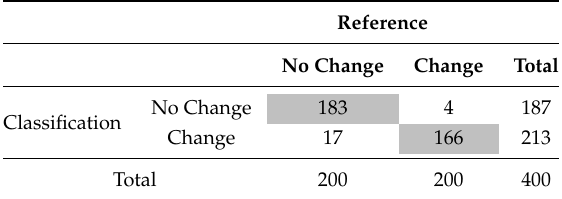
Table 5. Change detection validation for Rennes (OA = 94.75%; K = 0.90).